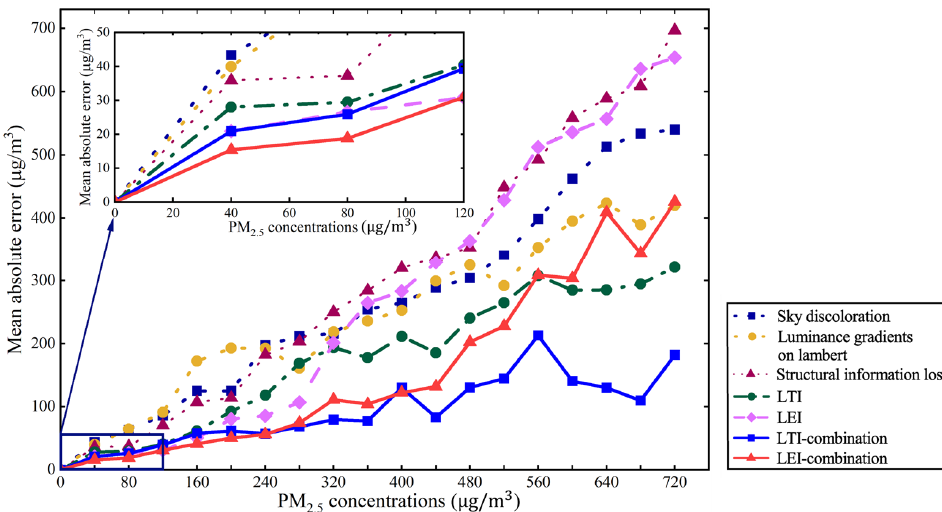
Figure 4. Performance comparisons of a single cue and cue combinations when estimating PM 2.5 concentrations based on the PhotoPM-daytime dataset.